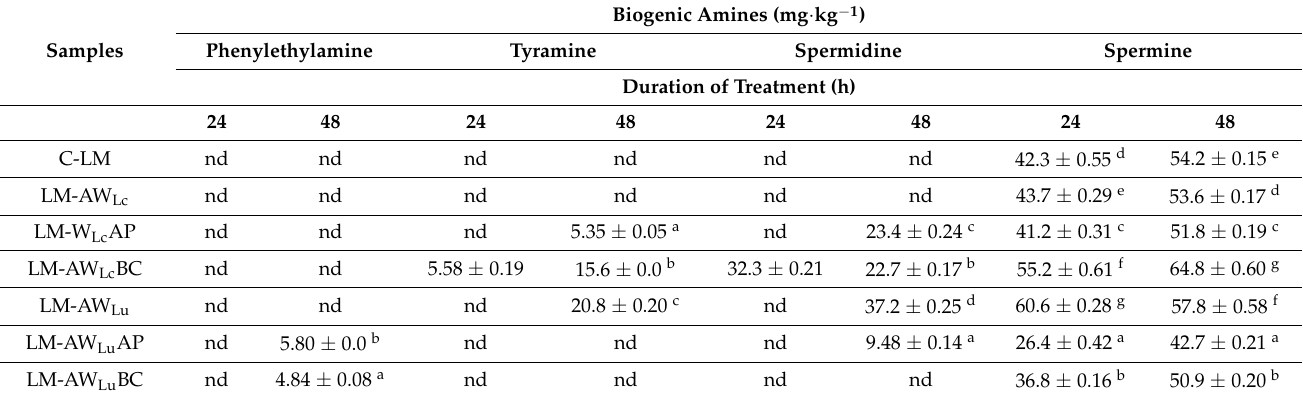
Table 8. The biogenic amine contents of the LM samples treated with the different